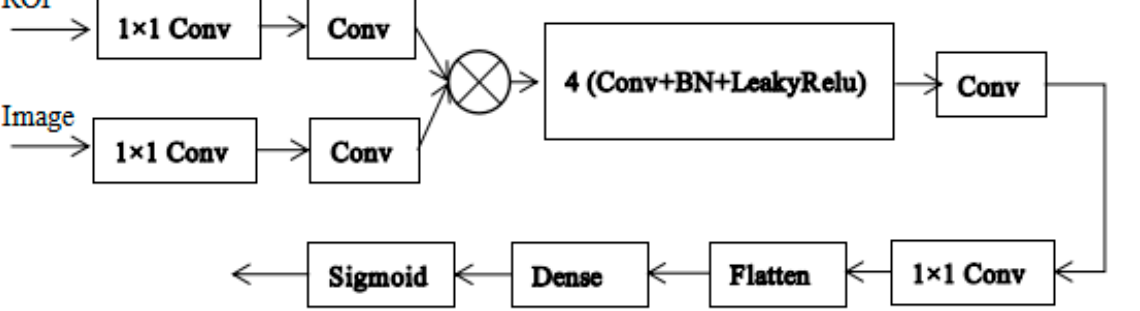
Figure 5. The network of the discriminator. The discriminator determines how close the predicted map is to the ground truth by using an evaluation score.